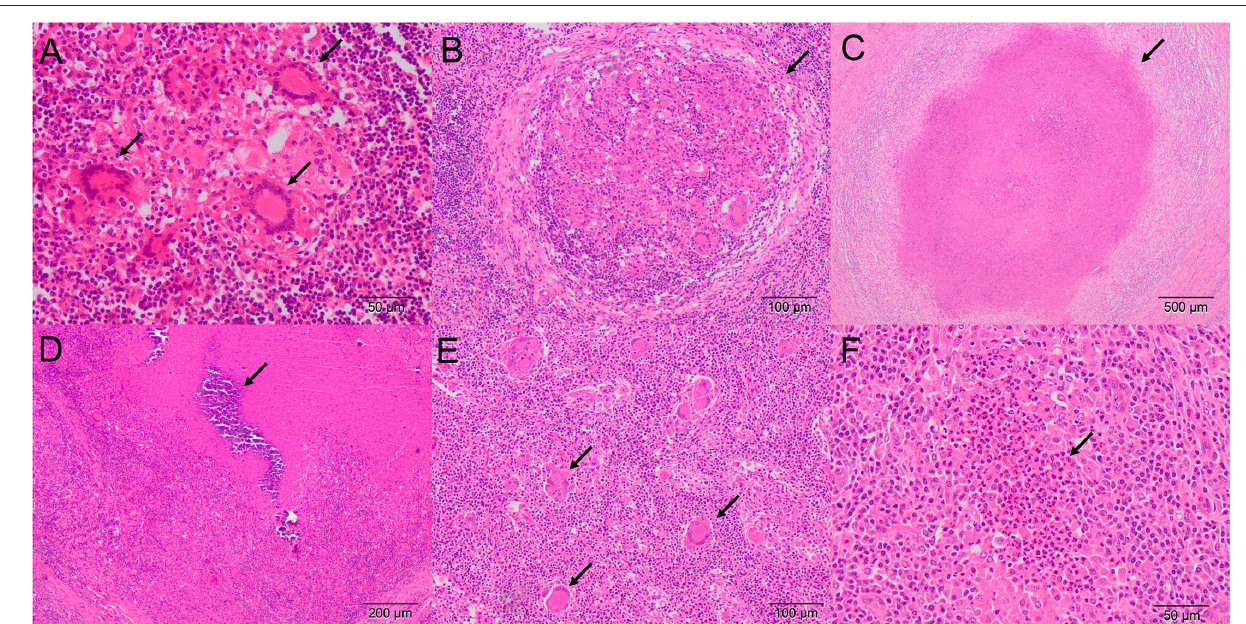
FIGURE 1 | Microscopic lesion of TBLs in LNs (H&E) (A) Tracheobronchial-mediastinal LN. Stage I granuloma showing clustered epithelioid macrophages with multinucleated giant cells (MNGCs; arrows) (B) Retropharyngeal LN. Stage II granuloma with abundant epithelioid macrophages, lymphocytes, MNGCs, and a fibrous capsule (arrow) (C) Mesenteric LN. Stage III granuloma showing a complete fibrous capsule and central necrosis with little mineralization (arrow) (D) Tracheobronchial-mediastinal LN. Stage IV coalescent granuloma with a complete fibrous encapsulation, extensive central necrosis, and mineralization (arrow) (E)